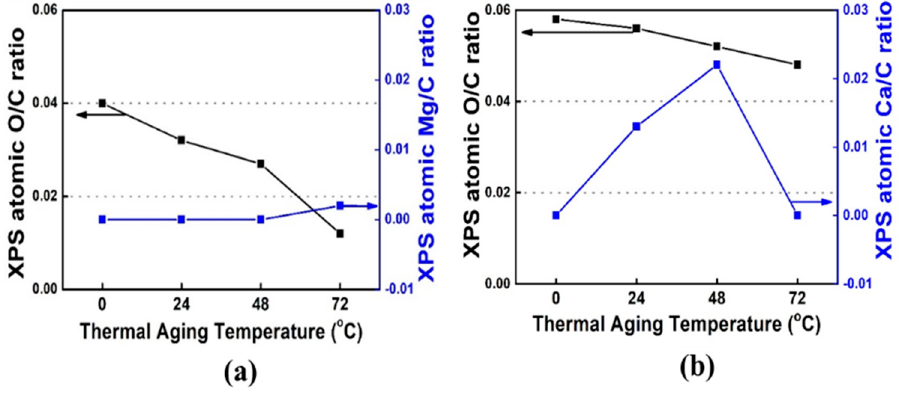
Figure 7. XPS atomic ratio of polypropylene/lubricant composites aged at different temperature conditions under 100% humidity: ( a ) PP/Mg; ( b ) PP/Ca.